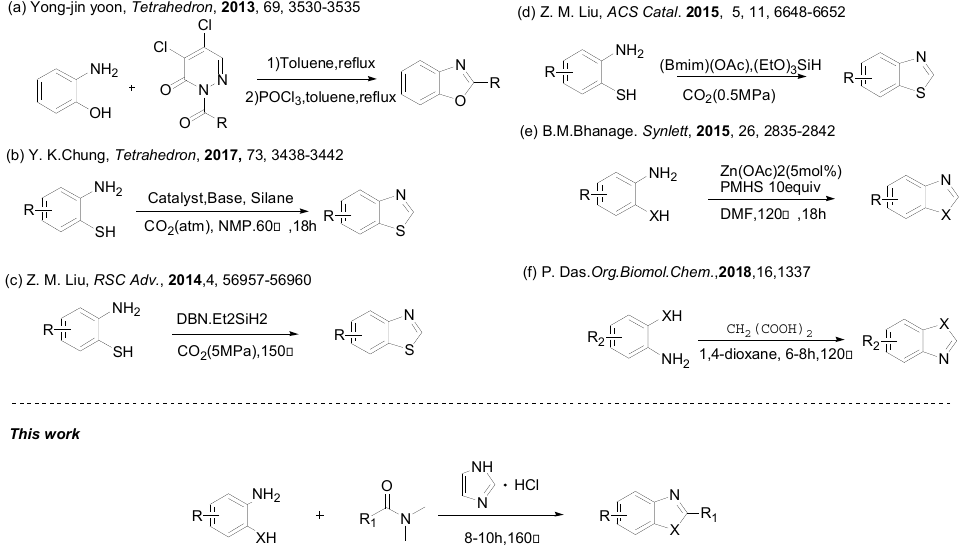
Figure 1. Biologically active benzoxazole and benzothiazole derivatives.